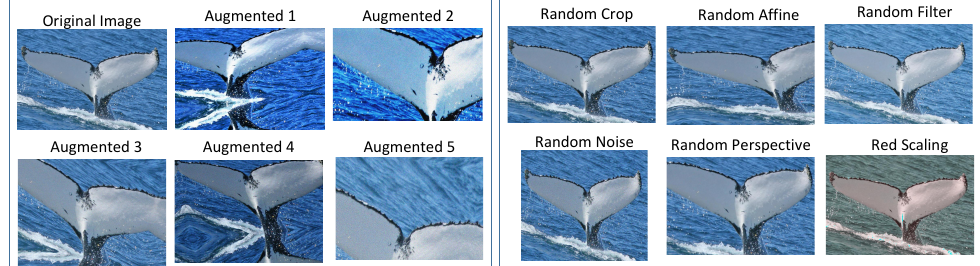
Figure 5. For a certain original picture, we randomly adopted several data enhancement methods. The execution order and number of executions of each method were random, and several data enhancement results could therefore be obtained. Here, we show one original image and five randomly-obtained images with corresponding data